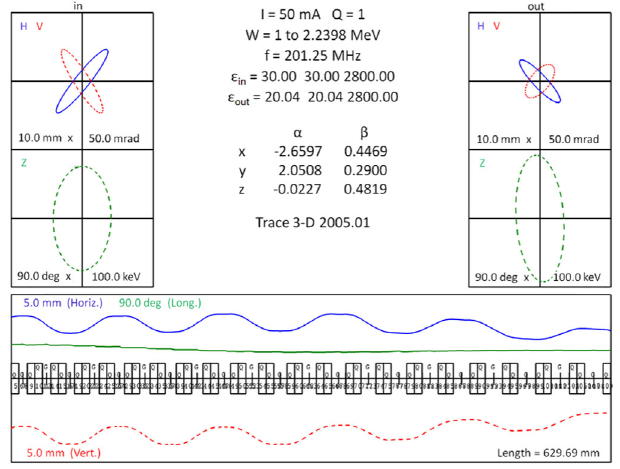
FIG. 15. Temperature distribution in IH1 at 10% duty. Cut-out view reveals the cooling channels inside the